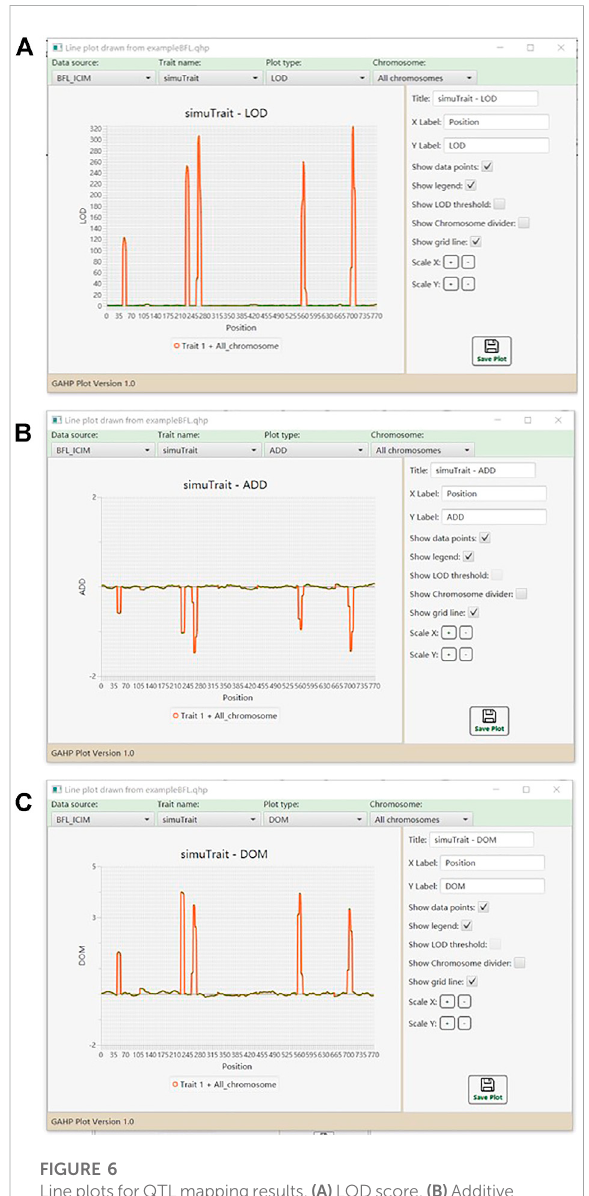
FIGURE 6 LineplotsforQTLmappingresults. (A) LODscore. (B) Additive effect. (C) Dominant